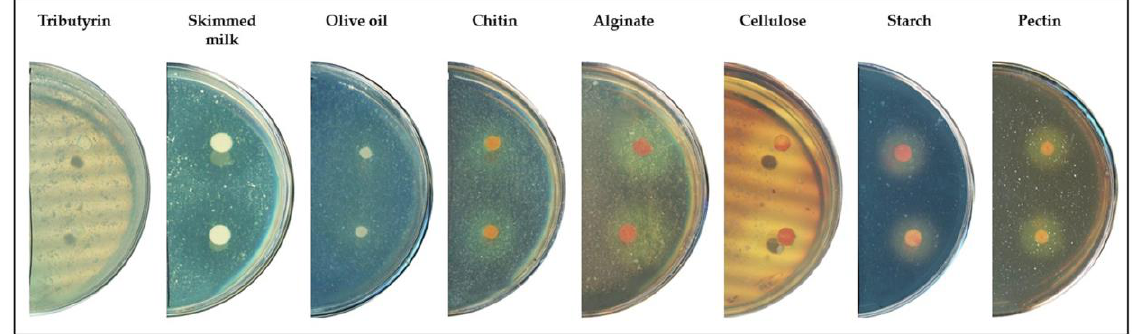
Figure 3. Antimicrobial activity of Saccharopolyspora sp. NFXS83 against Staphylococcus aureus ATCC 6538 in solid media. Halo measures ~1.39 cm. 3.3. Saccharopolyspora sp. NFXS83 Promoted the Growth of Phaeodactylum tricornutum CCAP 1055/1